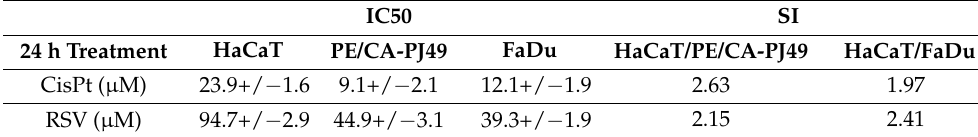
Table 1. IC50 (inhibitory concentration) values of the cisplatin and resveratrol were determined using a linear regression equation for the cytotoxicity curve for PE/CA-PJ49, FaDu tumor cells and for HaCaT normal cells. IC50 values are presented as mean ± SEM according to two independent assays, each done in triplicate. The Selectivity Index (SI) = IC50 of a compound in a normal cell line/IC50 of the same compound in a cancer cell line. SI values of more than 2 were considered as high